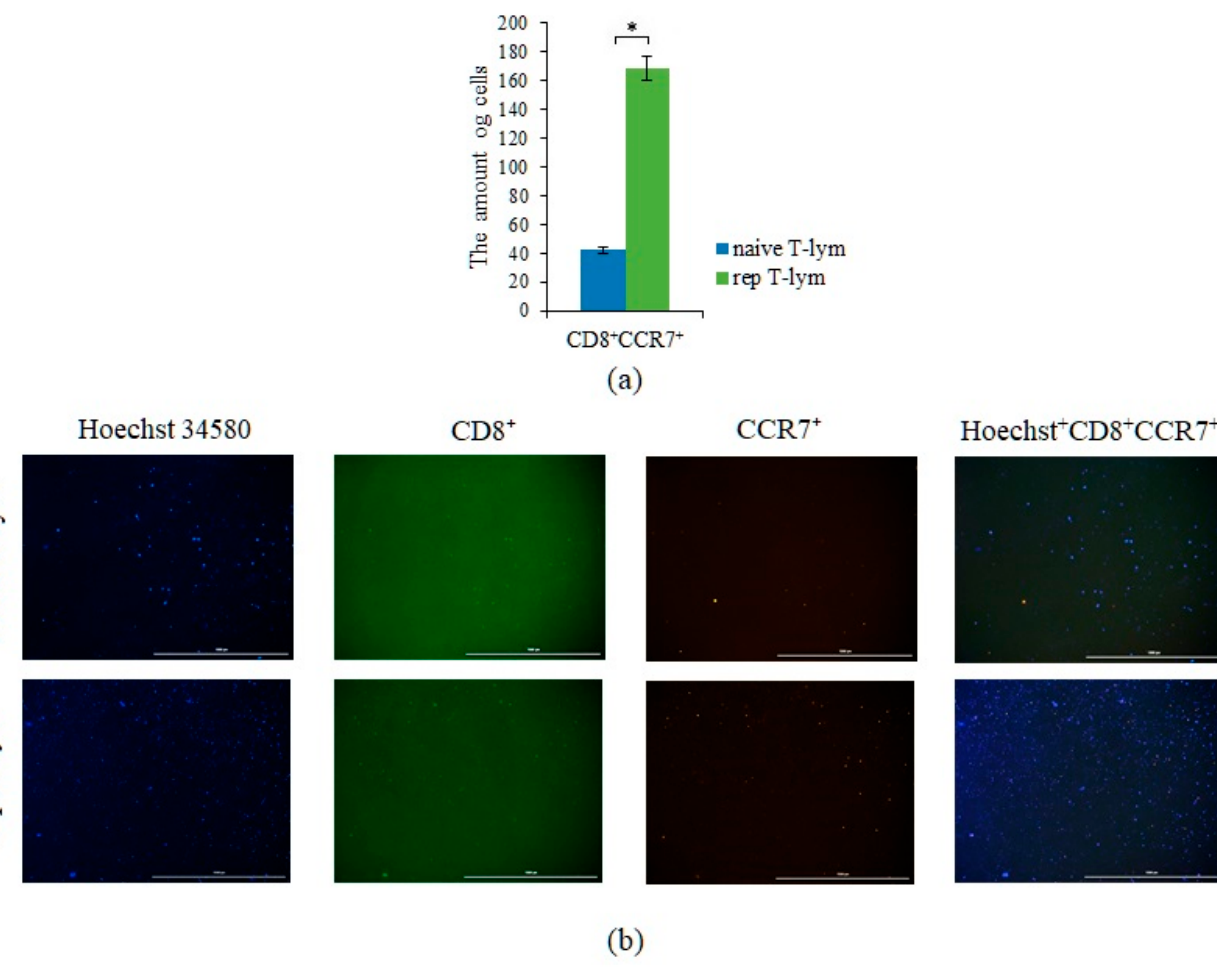
Figure 16. The count of CCR7 + T-cells in a culture of naive and reprogrammed CD8 + T-lymphocytes isolated from the blood of healthy volunteer. ( a ) The count of naive and reprogrammed CD8+ T-lymphocytes isolated from the blood of healthy volunteer expressing the CCR7 marker in T-lymphocyte culture; ( b ) 4 × images of T-cells stained with: Hoechst 34580 (blue) to identify cell nuclei: CD8 FITC (green), CCR7 AF555 (yellow), and (Hoechst + CD8 + CCR7 + ) composite image using all three colors. Determination of the percentage of cells CD8+CCR7+ is made by the ratio of cells counted in green and red channel to total cells counted using blue (DAPI) channel. All scale bars are 1000 µm. *—for comparison with the naive T-lymphocyte by Mann–Whitney test ( p < 0.05).